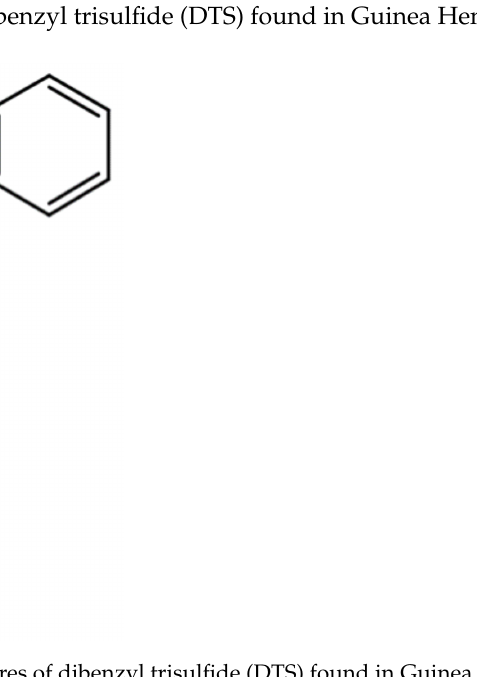
Figure 5. Chemical structures of dibenzyl trisulfide (DTS) found in Guinea Hen